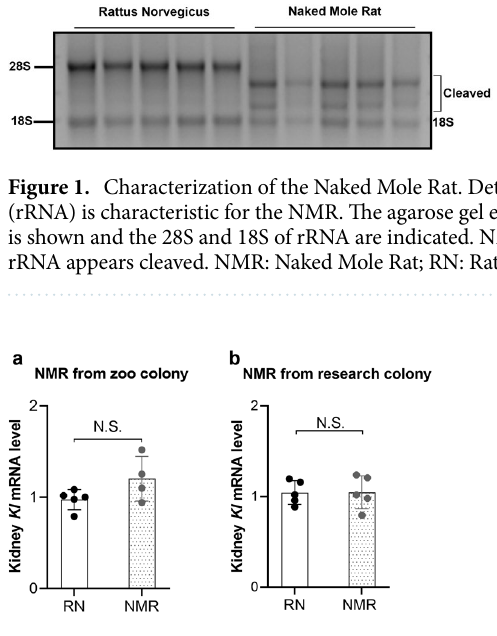
Figure 2. Expression of klotho in kidney from the Naked Mole Rat versus Rattus Norvegicus. Relative expression of Kl in kidney tissue from the NMR versus RN was measured by qPCR. The Kl expression was quantified and normalized to reference genes in the two experimental groups of NMRs (obtained from a zoo- and a research-colony) ( a , b ). Similar levels of Kl mRNA were found in the kidney of RN and NMR. Mean ± SD. * p < 0.05. n = 4–6 in each group. NMR: Naked Mole Rat; RN: Rattus Norvegicus; Kl : klotho